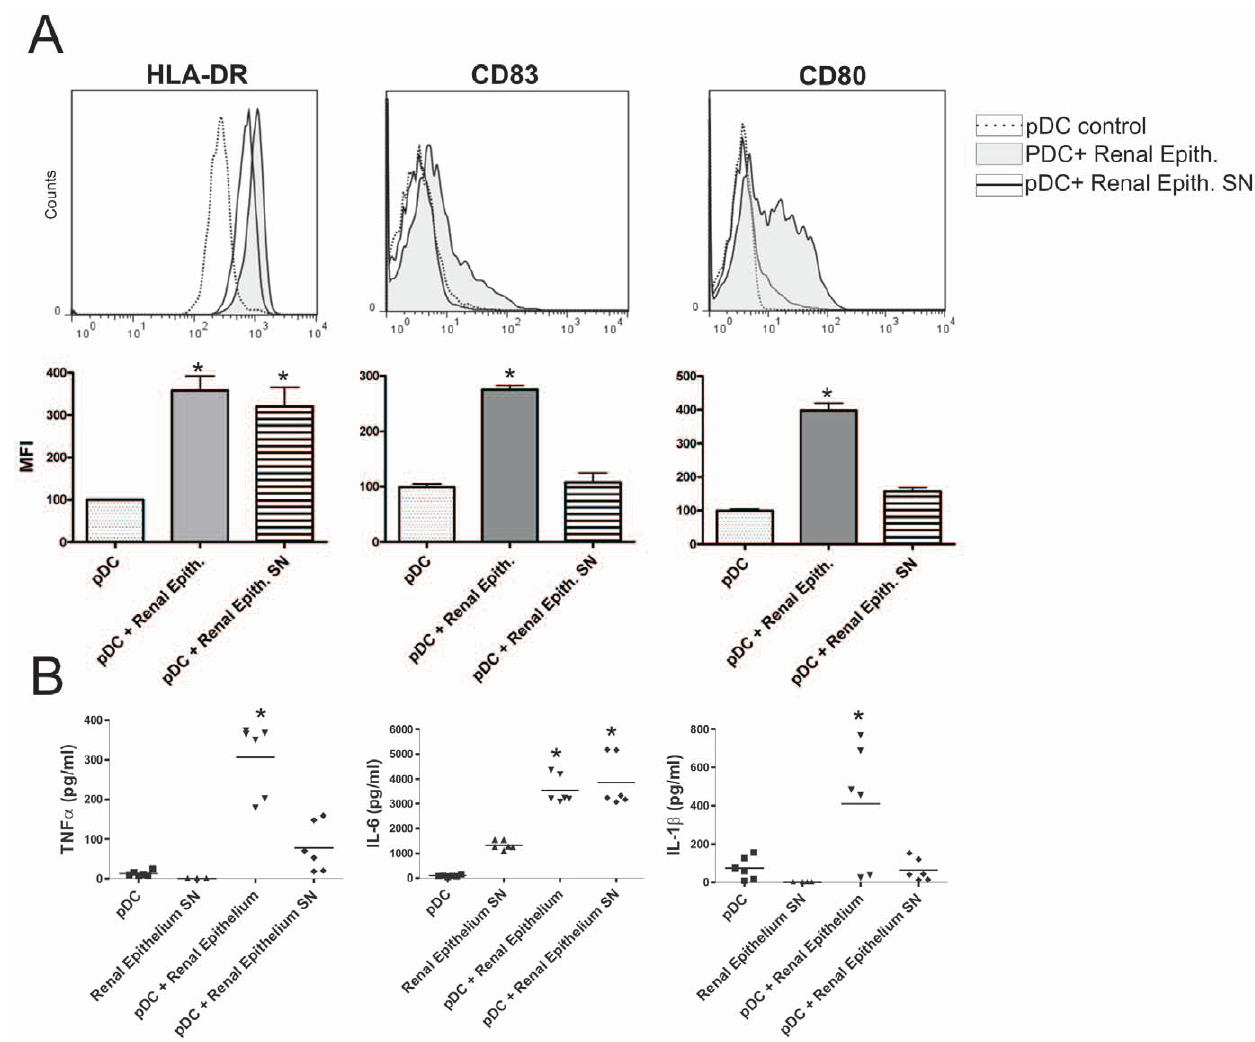
Figure 5. Primary human renal tubular epithelial cells (HRTEC) induce the activation of pDCs. Primary human renal proximal tubular cells, obtained as described under Materials and Methods, were grown to confluence in 96 well, flat bottom plates. pDCs (1 6 10 5 /well) were cultured for 12 h alone (controls), with confluent HRTEC, or with supernatants collected from confluent HRTEC incubated alone for 12 h. Then, the phenotype of pDCs in the gate of CD123 + cells was analyzed by flow (A) Histograms of representative experiments (n=6) are shown. The MFI of isotype controls were in all cases lower than 5 (not shown). Graph bars show the relative mean fluorescence intensity (MFI) of HLA-DR, CD83, and CD80 for pDCs cultured alone or in the presence of epithelial cells or epithelial cell supernatants. The MFI of pDCs cultured alone is assigned the value of 100. Results are the mean 6 SEM of 7–8 experiments performed in duplicate. (* p , 0.05 vs pDCs). (B) The production of TNF- a , IL-6, and IL-1 b were assessed in cell supernatants by ELISA. *p , 0.05 vs